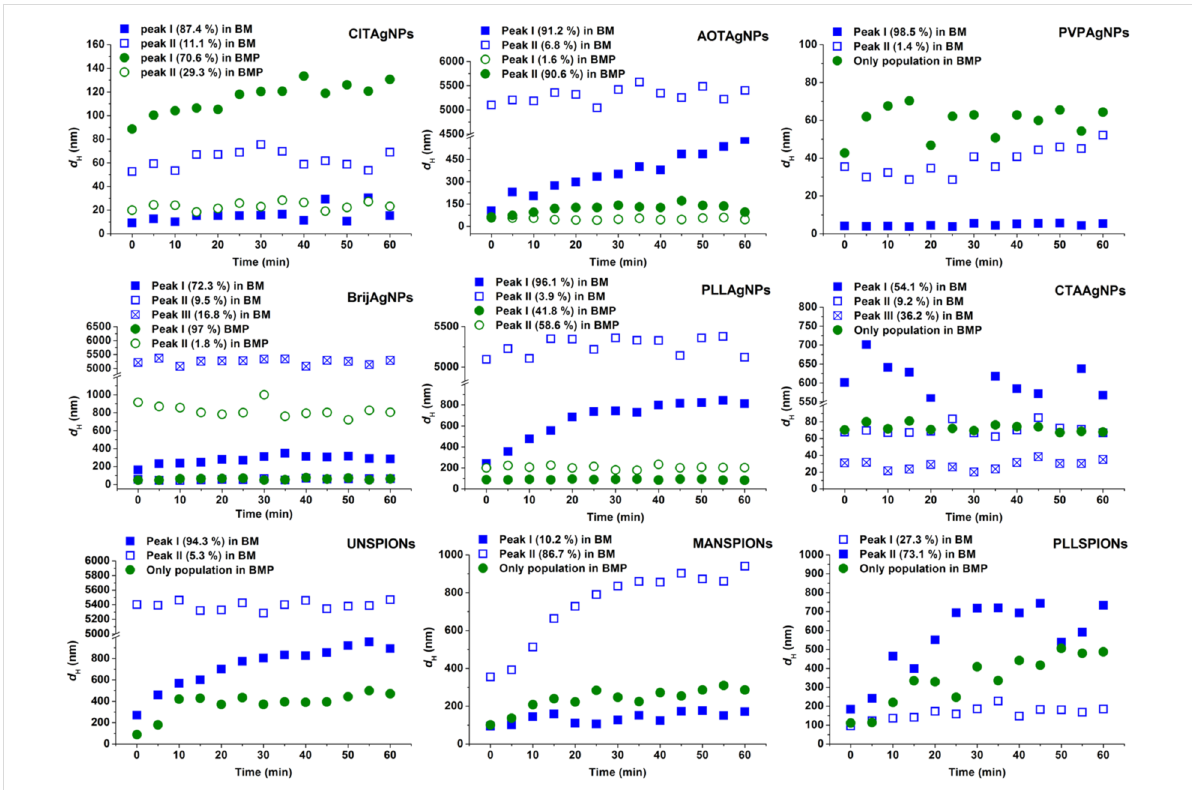
Figure 5: Temporal evolution of the hydrodynamic diameter ( d H ) obtained from size distributions by volume of differently coated metallic nanoparti- cles in biological media (BM) and biological media supplemented with 0.1% bovine serum albumin (BMP) over a period of 1 h at 25 °C. Results are presented for silver nanoparticles coated with trisodium citrate (CITAgNP), sodium bis(2-ethylhexyl) sulfosuccinate (AOTAgNP), poly(vinylpyrrolidone) (PVPAgNP), Brij 35 (BrijAgNP), poly(L-lysine) (PLLAgNP) , cetyltrimethylammonium bromide (CTAAgNP); and superparamagnetic iron oxide nanopar- ticles uncoated (UNSPION) and coated with D-mannose (MANSPIONs) and poly(L-lysine)